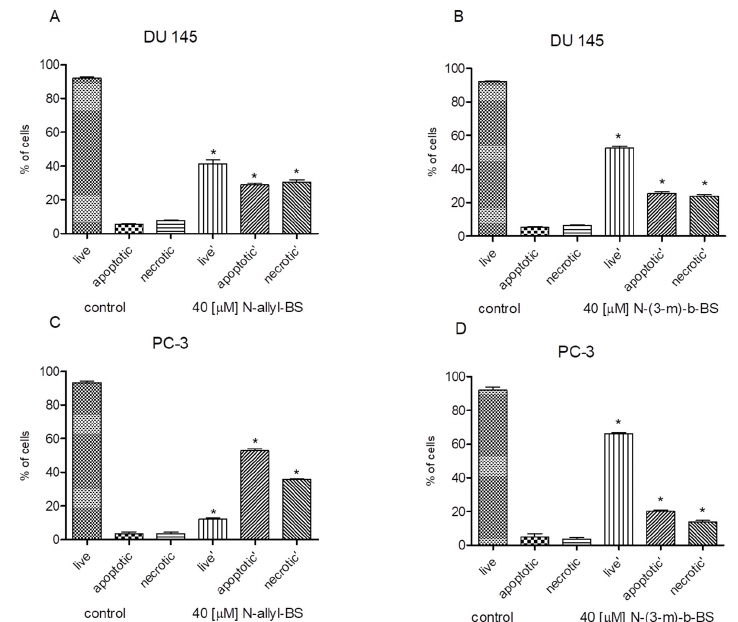
Figure 4. 40 µ M N -allyl-BS ( A,C ) and N -(3-mb)-BS ( B,D ) respectively induce apoptosis and necrosis of cancer cells after 24h treatment. Percentage of live, apoptotic and necrotic cells was determined by flow cytometry. The results are presented as a mean ± SE of three independent experiments. Significance of variations was determined by one-way ANOVA followed by Bonferroni’s multiple comparison test. (*P < 0.01).